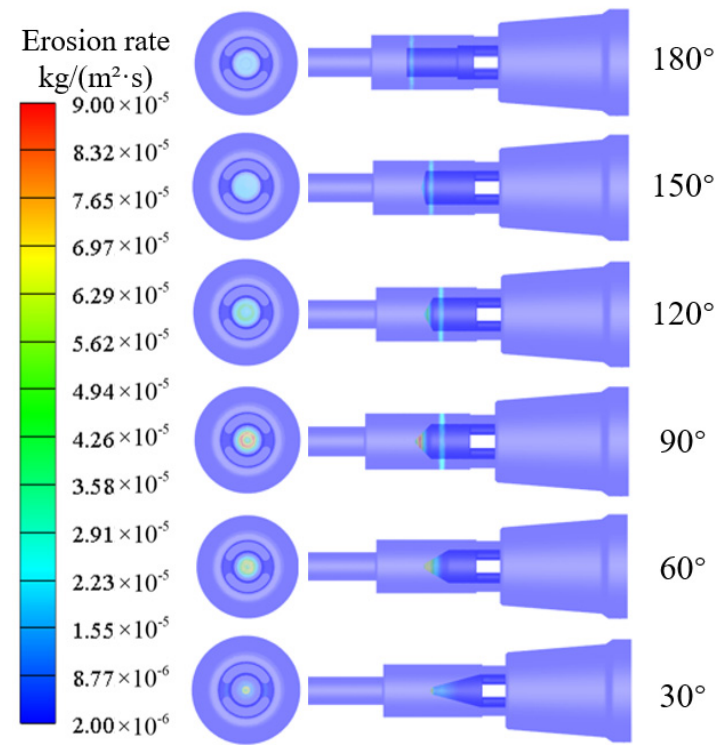
Figure 14. Erosion area changes with plug angle.